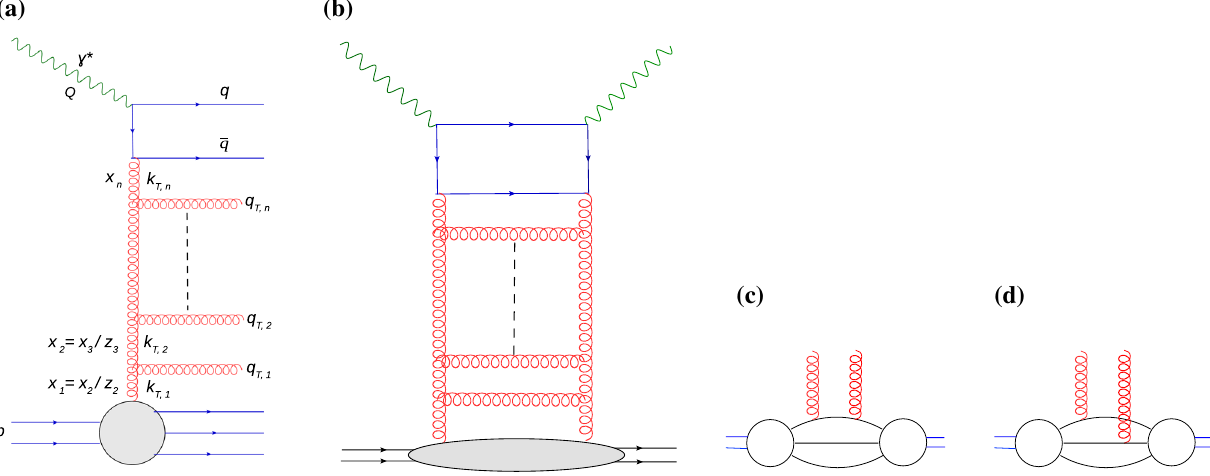
Fig. 1 From left: a chain of sequential gluon emission which forms the basis of BFKL equation. On squaring the amplitude of a the ladder diagram, b is generated which when summed gives the BFKL kernel.